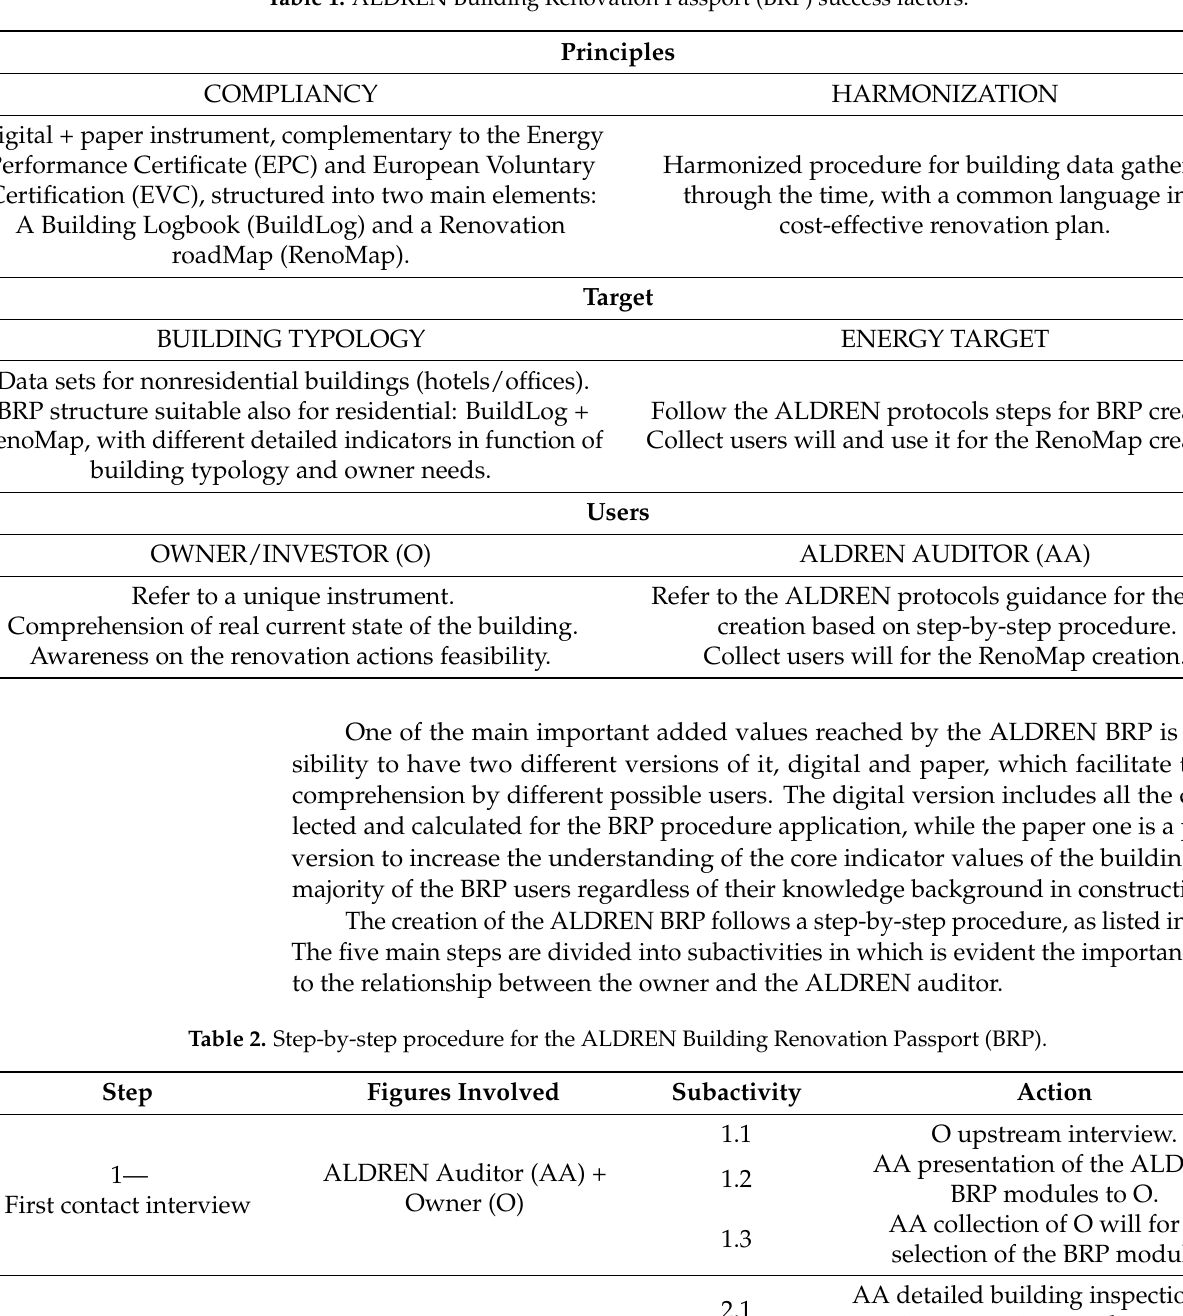
Table 1. ALDREN Building Renovation Passport (BRP) success factors.